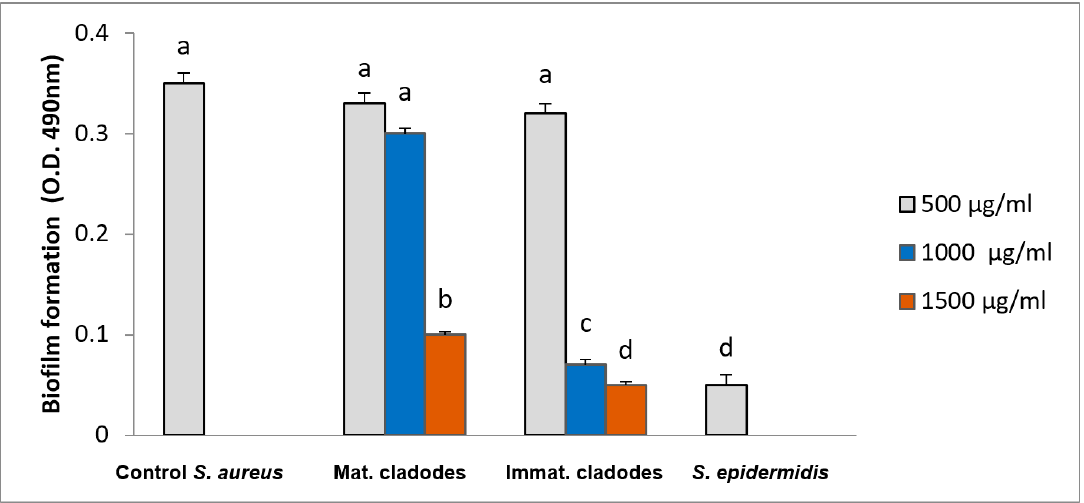
Figure 3. E ff ects of di ff erent concentrations of Opuntia ficus-indica cladode extracts on biofilm formation by Staphylococcus aureus ATCC 35556. Staphylococcus epidermidis ATCC 12228 was used as negative control. Assays were carried out in triplicate and the results were expressed as mean values ± SD. Di ff erent letters indicate significant di ff erences ( p ≤ 0.05). One-way ANOVA with Bonferroni’s multiple comparison